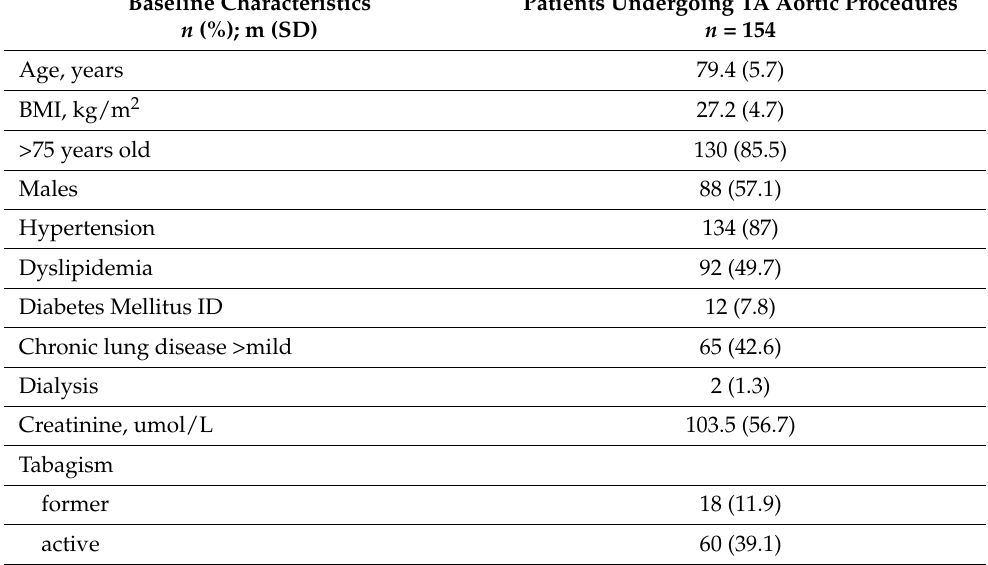
Table 1. Baseline